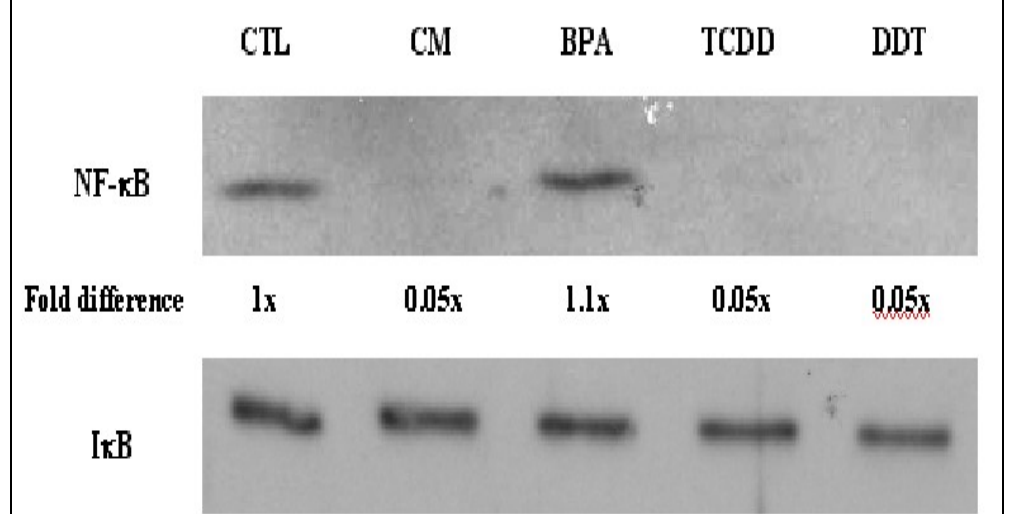
Figure 3. Western blot analysis of coumestrol, bisphenol A, TCDD and DDT effects on NF-kB in Jurkat T cell. Coumestrol, TCDD and DDT but not bisphenol A suppressed (0.05x of control) NF-kB protein levels in Jurkat T cells as assessed by Western blotting at 8 hrs (10 -6 M). Coumestrol, DDT, bisphenol A and TCDD induced had no effect on IkB protein in Jurkat T cells. Similar results were obtained in two additional